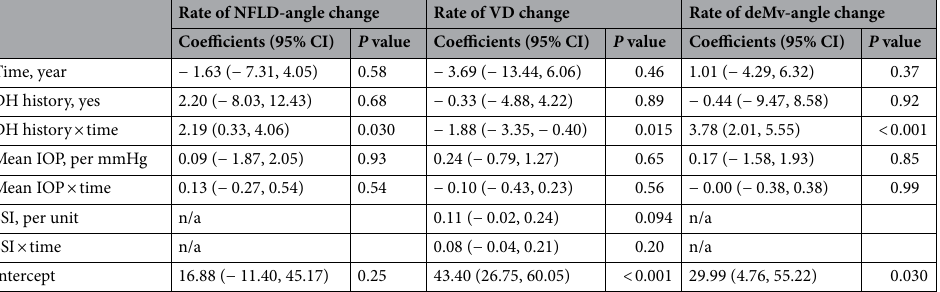
Table 3. Results of multivariable mixed effects model analysis for longitudinal changes in NFLD-angle, VD, and deMv-angle in NFLD quadrants. Rates of changes in deMv-angle and NFLD-angle are adjusted by IOP, and the rate of VD change is adjusted by IOP and SSI. CI confidence interval, deMv decreased superficial retinal microvasculature, DH disc hemorrhage, IOP intraocular pressure, NFLD nerve fiber layer defect, SSI signal strength index, VD vessel density, n/a not